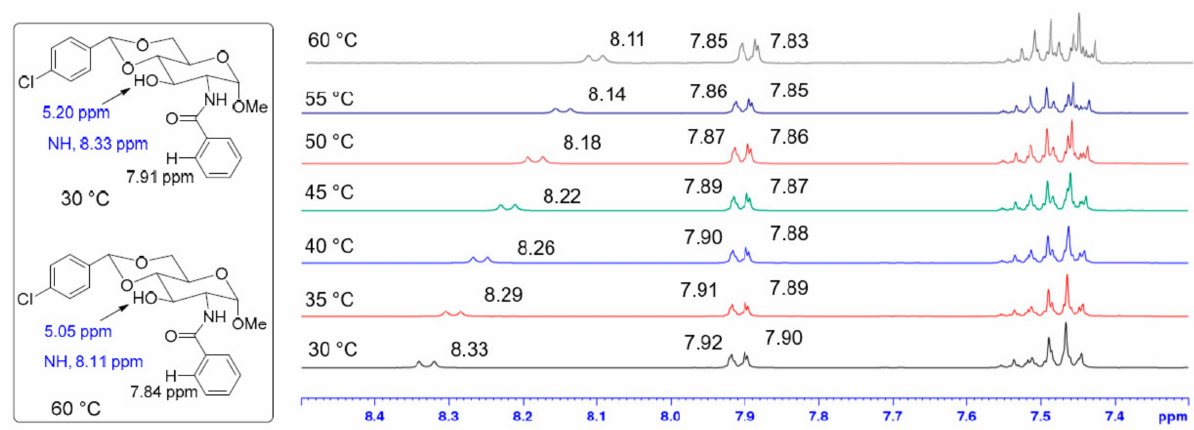
Figure 6. Stacked 1 H-NMR (400 MHz) spectra of compound 3 at temperature 30–60 ◦ C. The sample was prepared at 12.5 mg/mL in DMSO-d 6 .